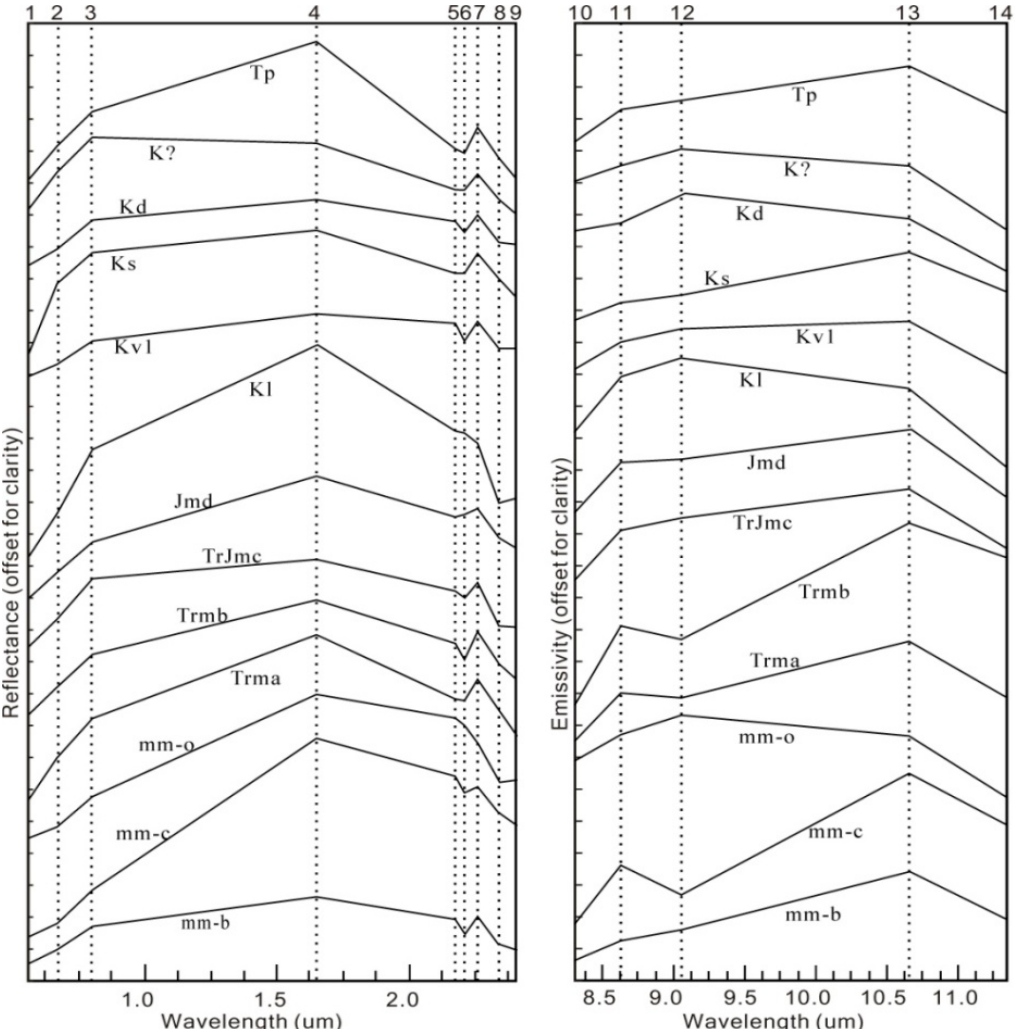
Figure 8. ASTER image spectra of important lithologic units in the study area. T p —Tertiary potassic intrusive rocks; K d —Cretaceous diorites; K s —Cretaceous red beds; K v1 —Cretaceous basaltic rocks; K l —Cretaceous carbonates. Tr ma , Tr mb , TrJ mc and J md represent the four subunits of the MG sedimentary successions. Three lithologic types of the MG mélanges ( mm ): mm-o for components dominated by oceanic basalts, mm-c for components dominated by chert and mm-b for components dominated by sedimentary materials. See text for detailed description of the lithologic units.